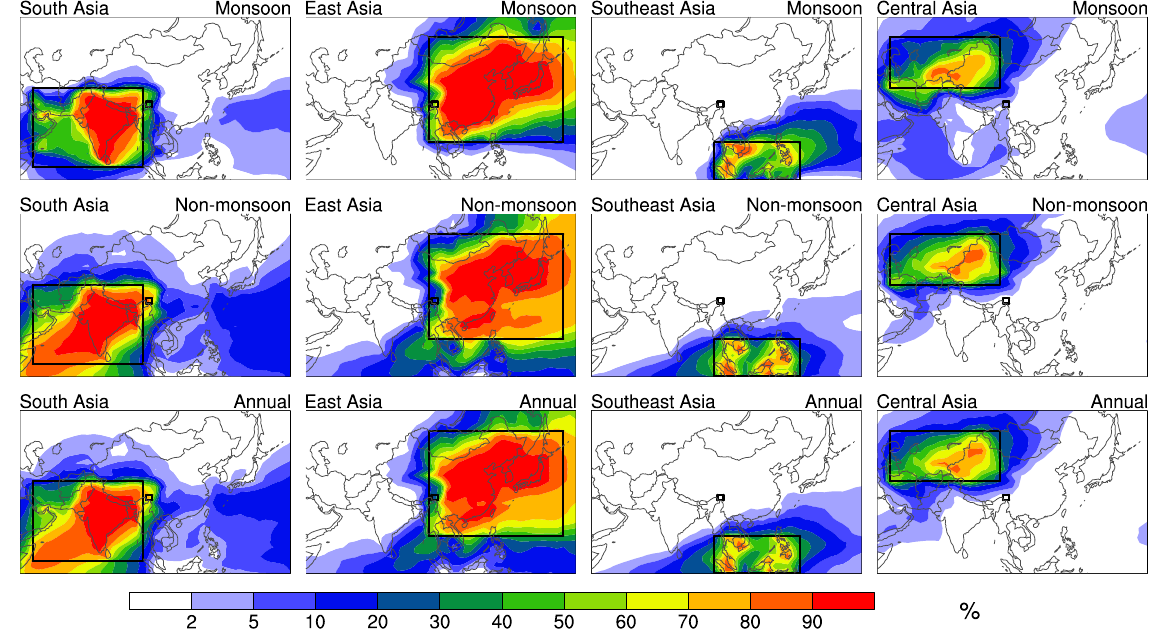
Figure 4. Spatial distributions of fractional contribution from the four source regions (South Asia, East Asia, Southeast Asia, and Central Asia) to monsoon, non-monsoon, and annual mean BC deposition fluxes during 1996–2005. The large black boxes indicate the boundary of source regions, and the small black box marks the model grid cell where the Zuoqiupu drilling site is located. Color in the small black box in each panel corresponds to the fraction contribution to BC deposition at the sampling site. Exact percentage contributions are provided in Table 1.